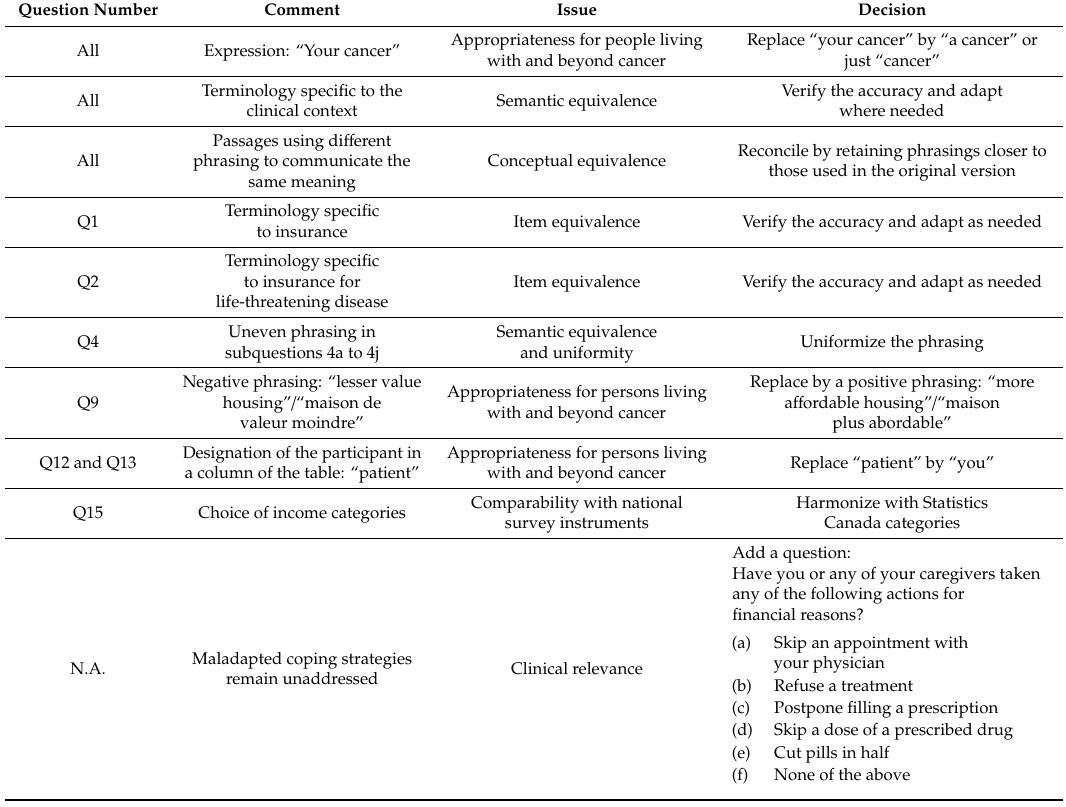
Table 1. Summary of expert committee comments made during the translation and cultural adaptation